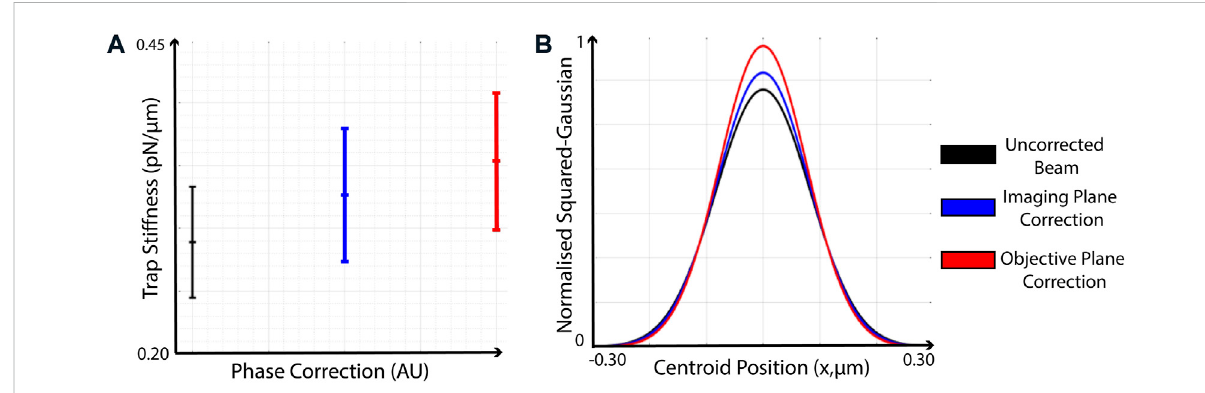
FIGURE 4 Improvement in optical trap stiffness when applying phase corrections in the conjugate and Fourier planes. Both fi gures are generated using centroidmeasurementsfromanopticallytrapped3 μ mpolystyreneparticle,using5kframescapturedat100FPS. (A) Opticaltrapstiffnesscalculated using the uncorrected beam, beam with phase-correction applied as found in the conjugate plane of the SLM, and the corrected beam using in-situ (Fourier plane) phase correction at the focus of the microscope objective. (B) Normalised, Squared-Gaussian fi t using from the histograms of particle positions used in (A) .